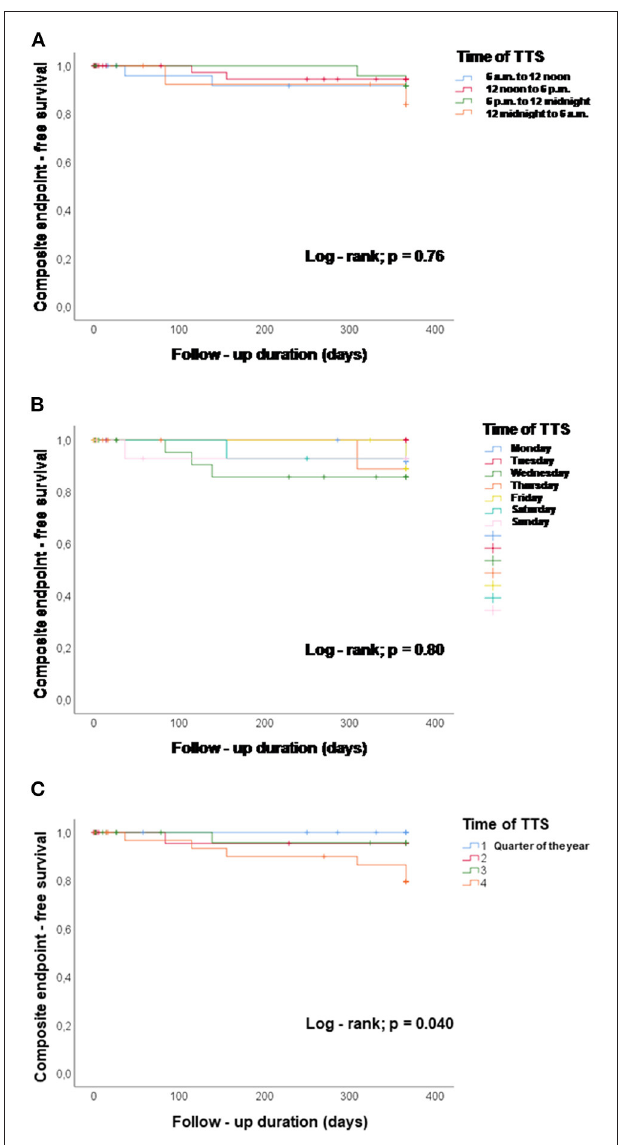
FIGURE 2 | Chronobiological distribution of TTS events and event-free survival (events are defined by the composite endpoint consisting of thromboembolic events, life-threatening arrhythmias, all-cause mortality, re-hospitalization due to heart failure, stroke, myocardial infarction and recurrence of TTS rate). (A) TTS events taking place during the four 6h units of the day were not associated with the event-free survival during 1 year, log-rank p = 0.76. (B) Time onset of TTS during the day of the week did not impact the event-free survival, log-rank p = 0.80. (C) Patients with TTS in the fourth quarter of the year showed a lower event-free survival rate compared with the other patients, p = 0.04, quarter of year 4 vs. quarters of year 1–3.